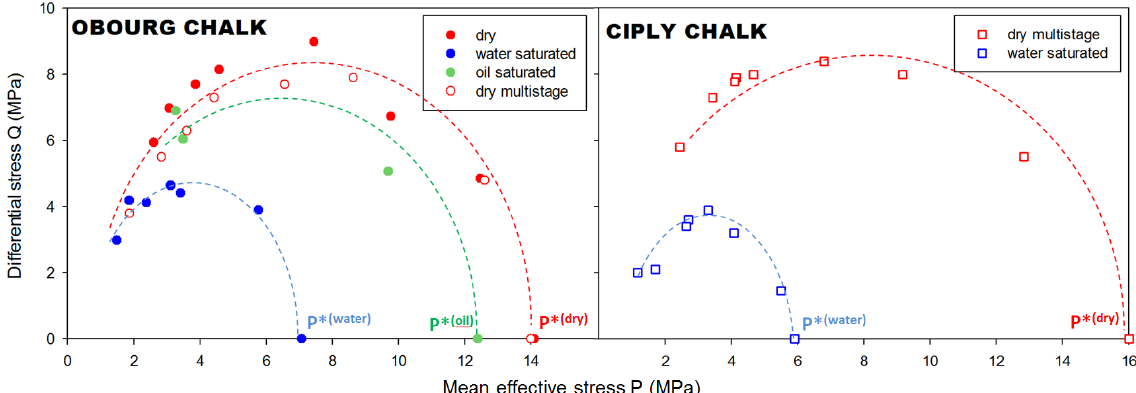
Figure 10. Yielding envelopes obtained from the yield stresses for both chalks saturated with different fluids. Solids symbols are for conventional triaxial tests, open symbols are for data obtained using a multistage loading approach on a single sample. The y -axis scale is the same for both plots.